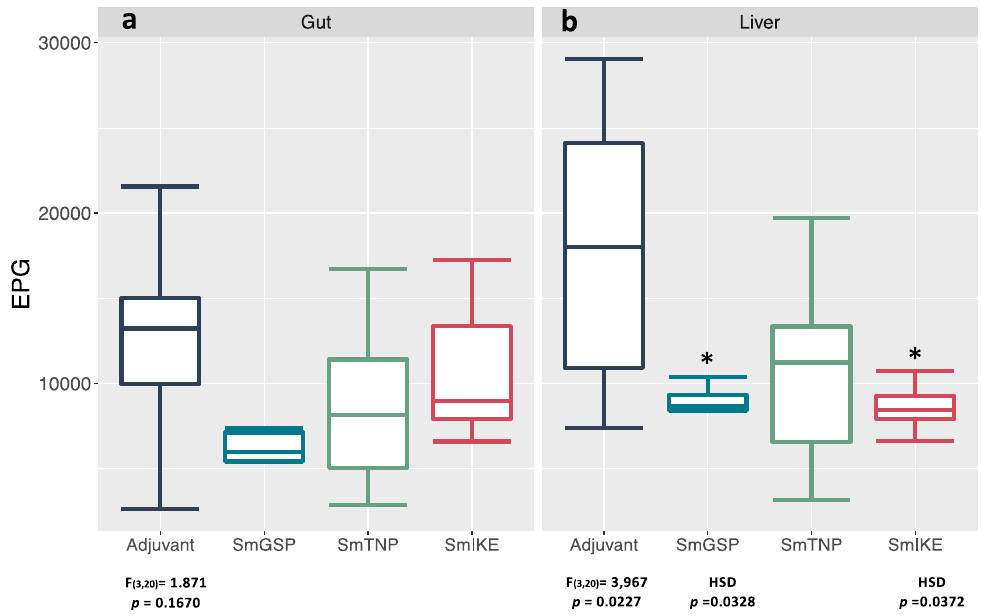
Figure 3. Egg burden in tissues (eggs per gram, EPG): ( a ) in the gut and ( b ) liver of BALB/c mice vaccinated with SmGSP, SmTNP and SmIKE formulated in the ADAD vaccination system with AA0029 and Quilaja saponaria saponins at eight weeks post- Schistosoma mansoni challenge. * Statistically significant differences ( p < 0.05) were determined by analysis of variance (ANOVA) and post hoc Tukey’s test (HSD).